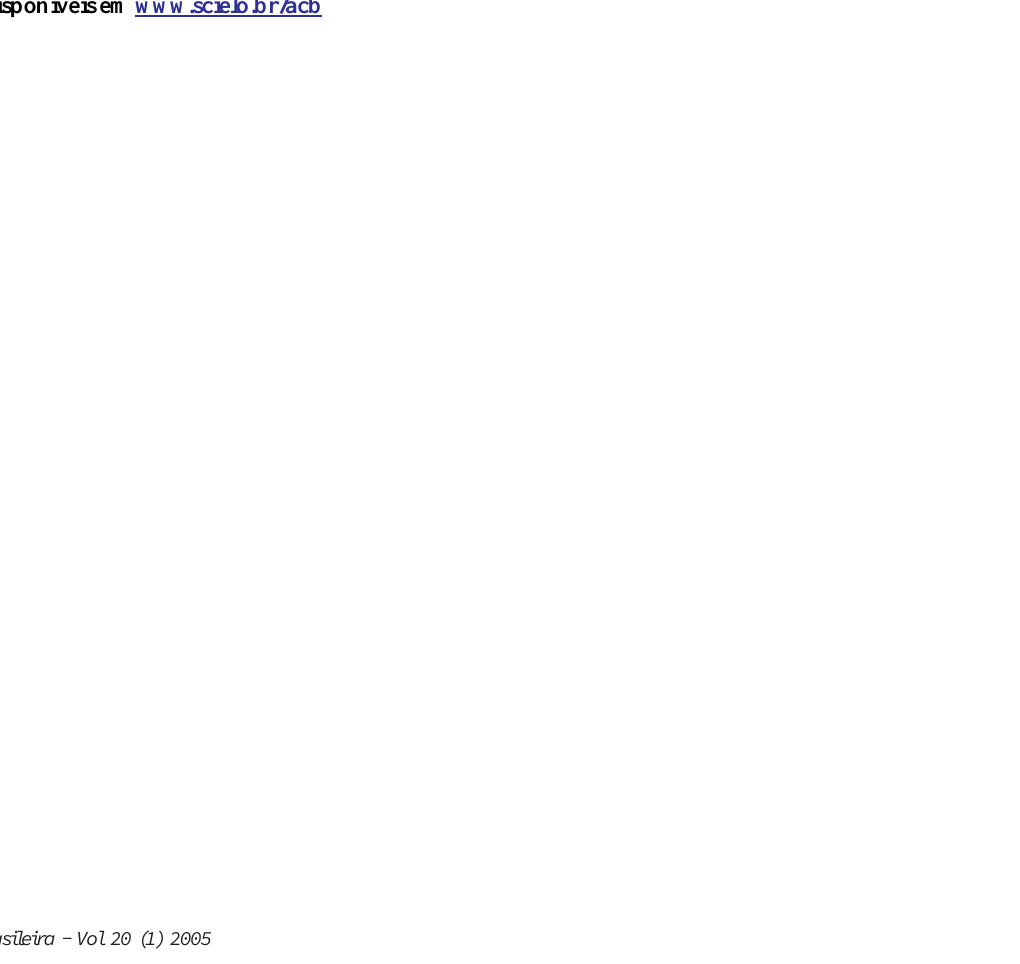
*Figuras coloridas disponíveis em